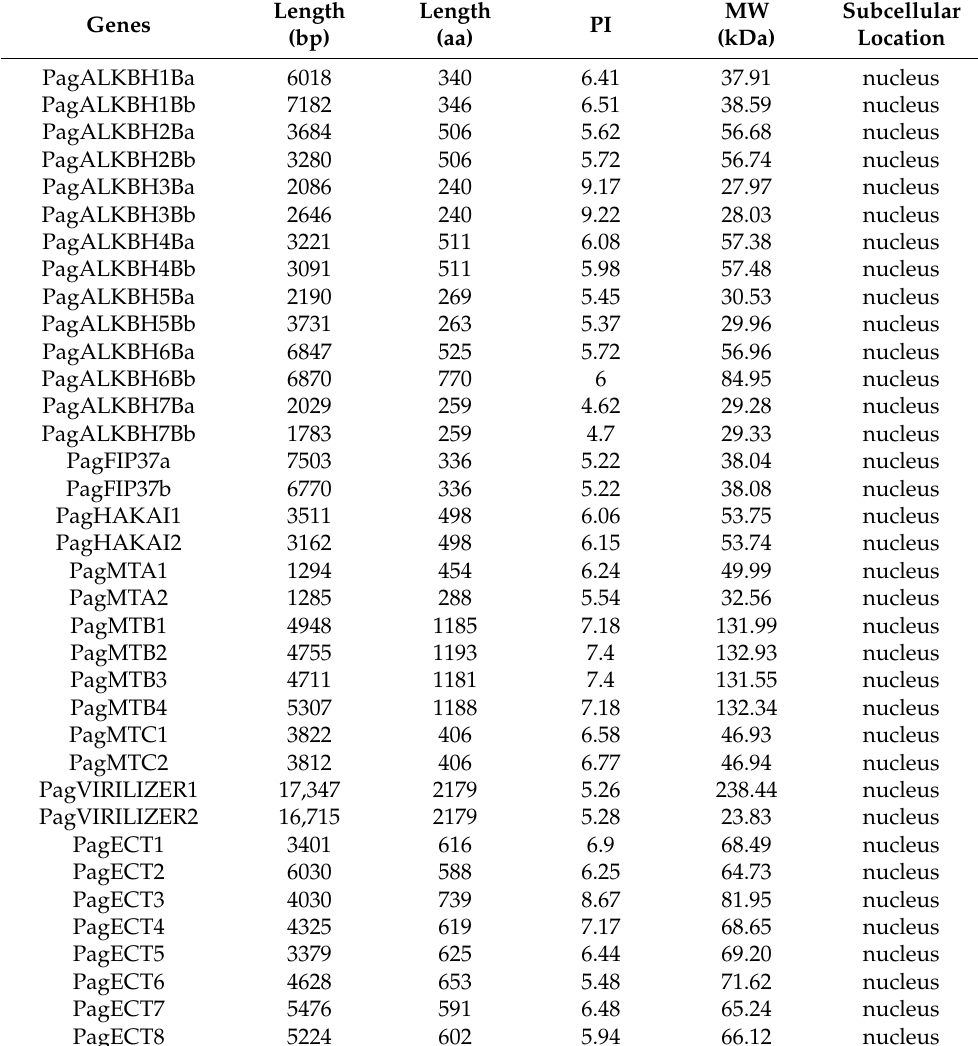
Table 1. Sequences feature of m 6 A pathway genes in Poplar